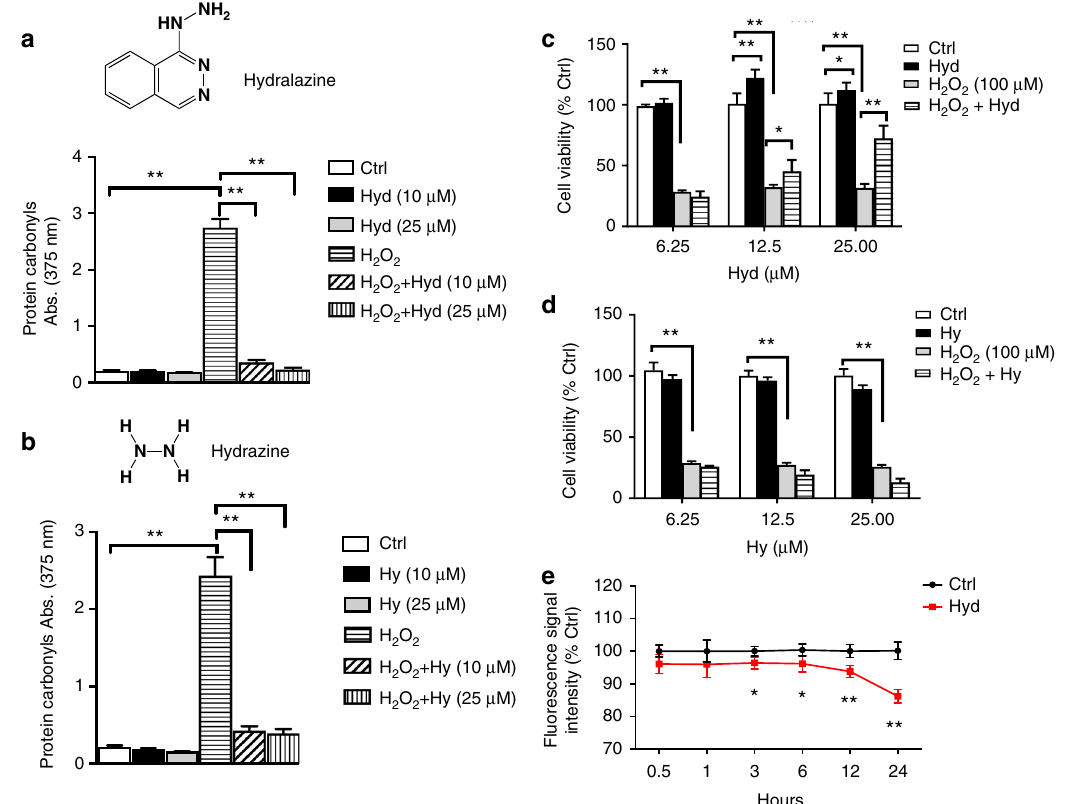
Fig. 1 Hydralazine protects SH-SY5Y cells from oxidative stress induced cell death. a Protein carbonyls were measured using 2-DNPH assay in SH-SY5Y cells treated with hydralazine, H 2 O 2, or both. Hydralazine treatment signi fi cantly reduced the carbonyl concentration raised by H 2 O 2 treatment. ** p < 0.01, two-tailed Student's t test, n = 6, mean ± SD. b Hydrazine, a compound with the same aldehyde chelating functional group as hydralazine, reduced the concentration of carbonyls in the lysate. ** p < 0.01, two-tailed Student's t test, n = 6, mean ± SD. c The viability of cells under H 2 O 2 induced stress was signi fi cantly improved with hydralazine treatment. * p < 0.05 and ** p < 0.01, two-tailed Student's t test, n = 6, mean ± SD. d Hydrazine treatment did not rescue cells from H 2 O 2 stress, indicating that the hydralazine mode of action did not depend on carbonyl sequestration. ** p < 0.01, two-tailed Student's t test, n = 6, mean ± SD. e ROS were measured using a DCDFA assay. Hydralazine treatment of SH-SY5Y cells (10 µ M) did not increase ROS 30min after treatment and beyond, con fi rming that hydralazine itself does not cause oxidative stress. * p < 0.05 and ** p < 0.01, two-tailed Student's t test, n = 8, mean ±